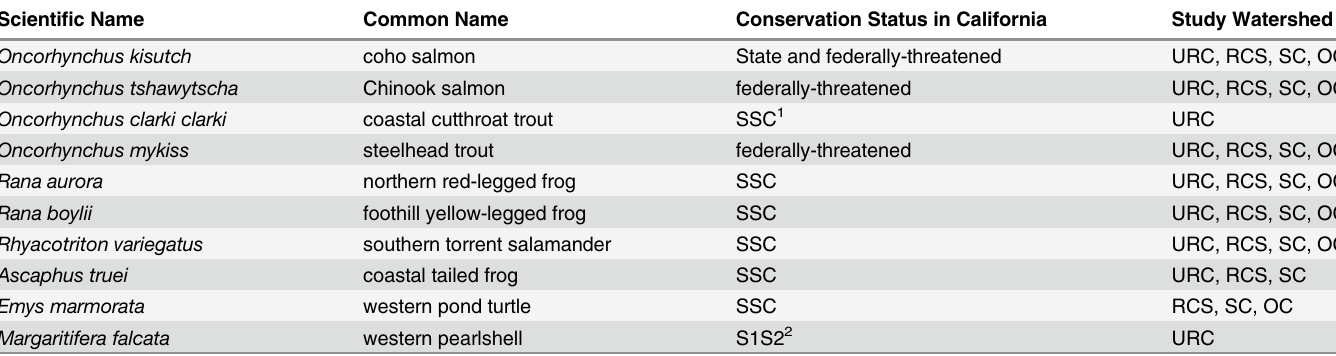
Table 5. Sensitive aquatic species with ranges that overlap the four study watersheds: Upper Redwood Creek (URC), Redwood Creek South (RCS), Salmon Creek (SC), and Outlet Creek